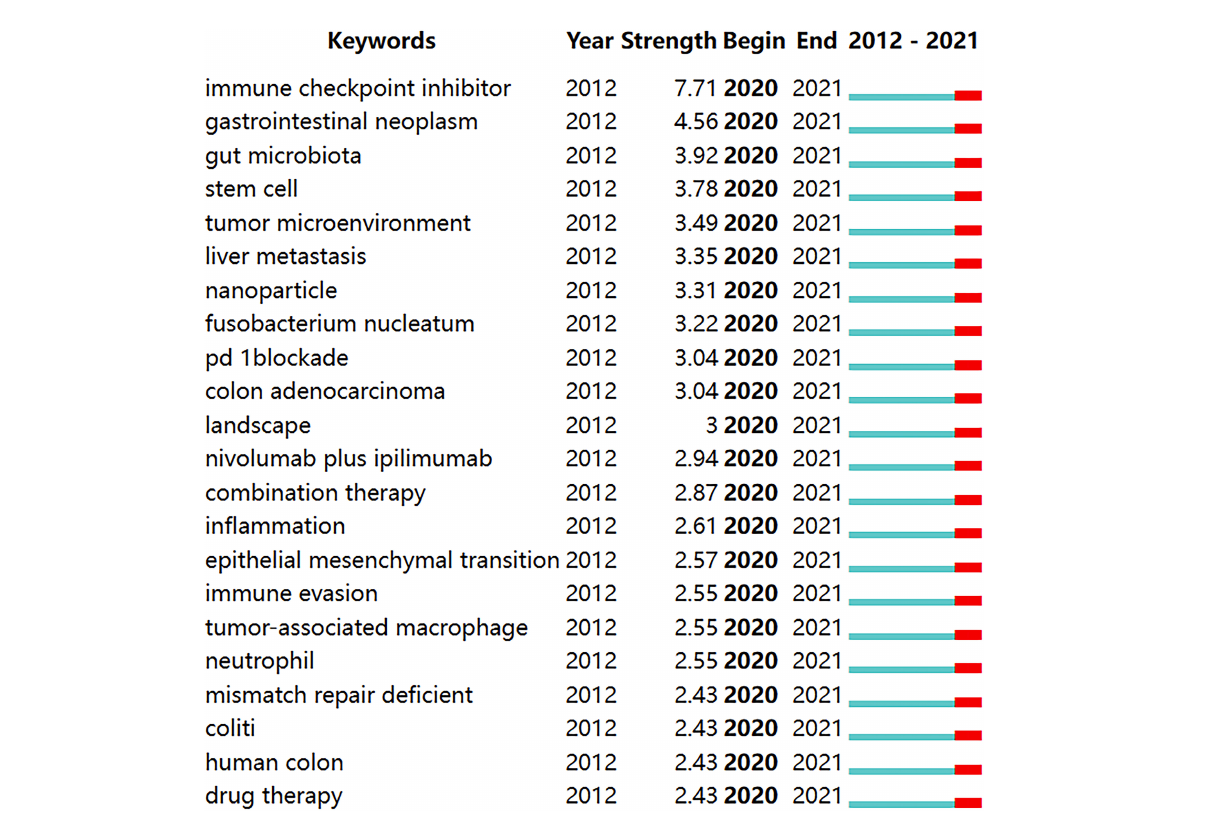
FIGURE 9 | Keywords with burst periods from 2020 onward among the top 103 burst keywords in articles related to colorectal cancer immunotherapy. A blue line indicates the timeline, and the intervals in which bursts were found are indicated by red sections on the blue timeline, indicating the start year, the end year, and the burst